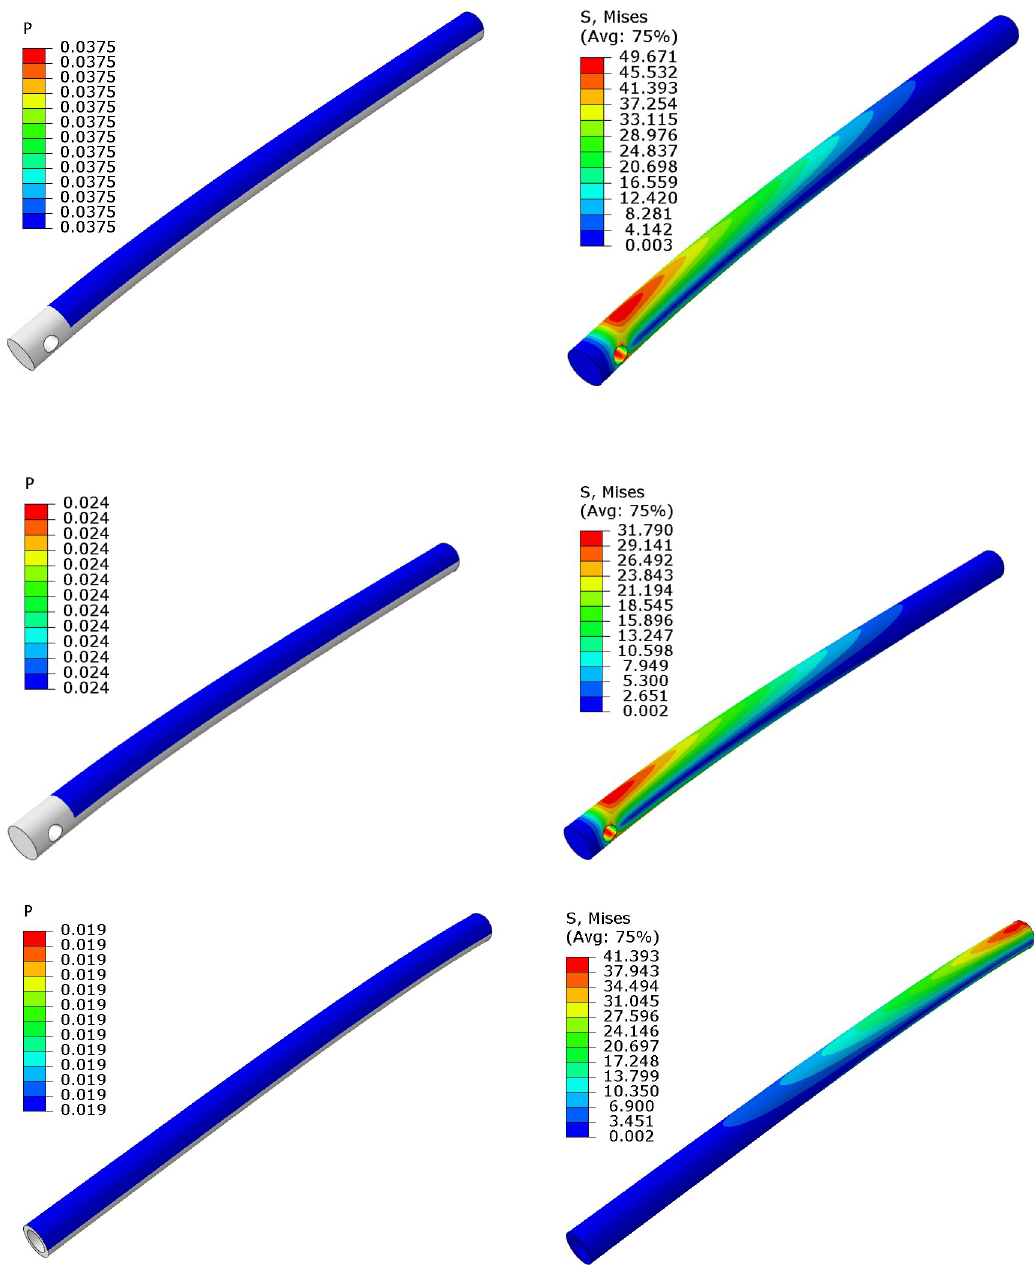
Fig 38. FEM analysis results for the maximum pressure ( P ), tolerable by a) PP for PETG manufacture’s specification, b) PP made with poor 3-D printing and c) PP with PVC